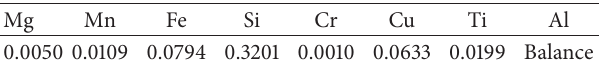
Table 1: Aluminum composition %